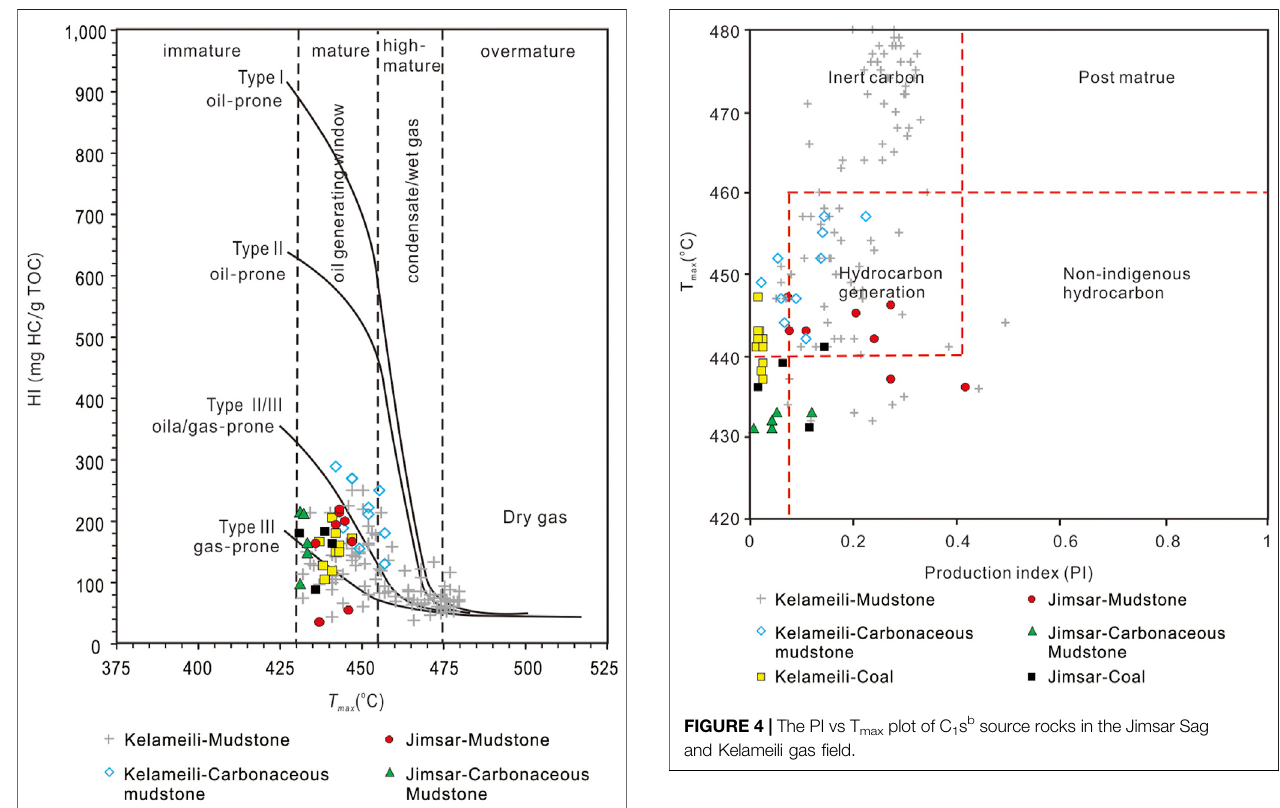
Frontiers in Earth Science |